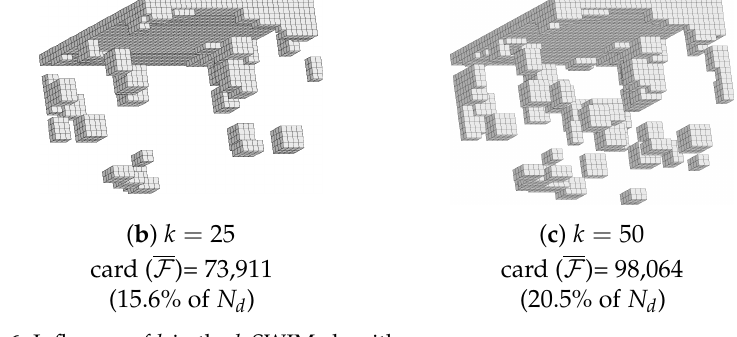
Figure 6. Influence of k in the k -SWIM